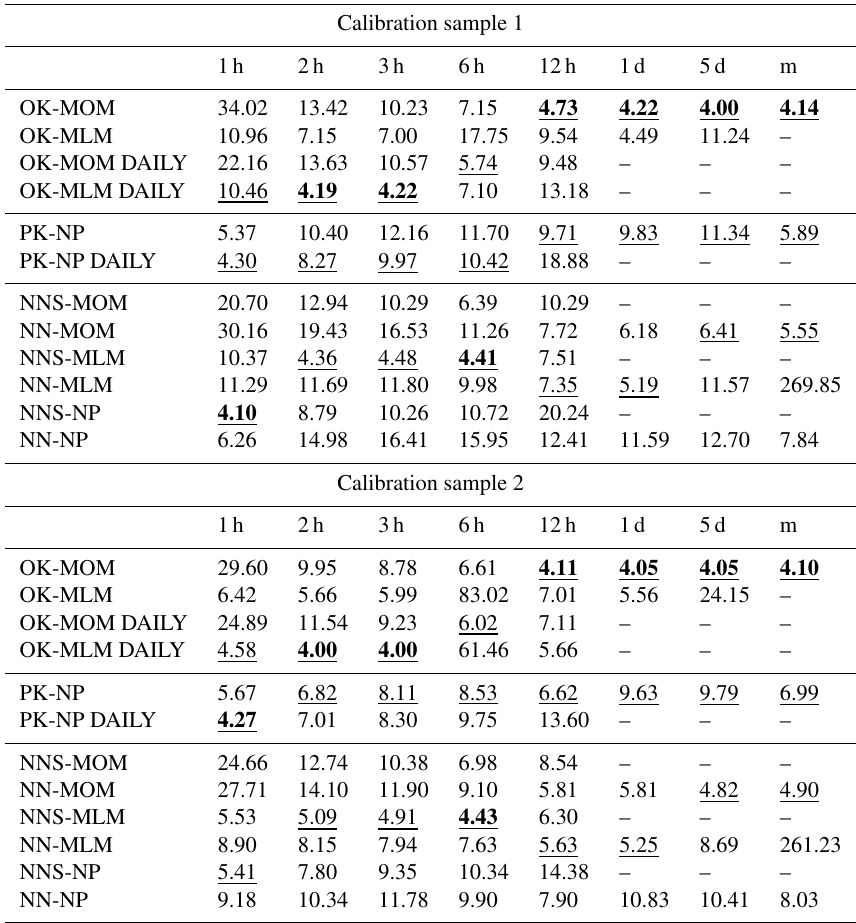
Table 6. The performance ranking numbers for the 2-fold cross-validation of the regionalized precipitation amount models in the summer season. The underlined numbers indicate the best parametric (P) and nonparametric (NP) models. The bold numbers indicate the best overall model for each validation sample and temporal